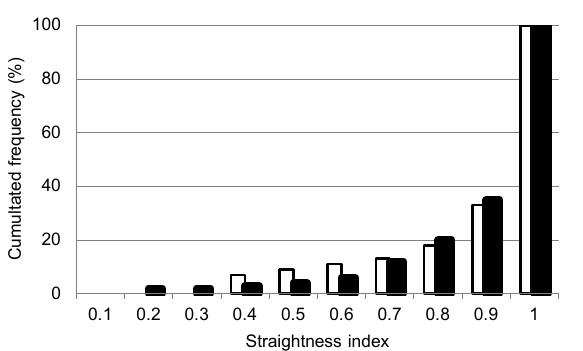
Figure A2. Diagram of the experimental set up, showing the sonar beams covering the channel, bank to bank. On the right, an example of a sonar picture where the dynamic echoes of fish school (inside the circle, in t 1 , t 2 and t 3 ) were discriminated from the fixed echoes of the bottom (Reprinted with permission from [9]).